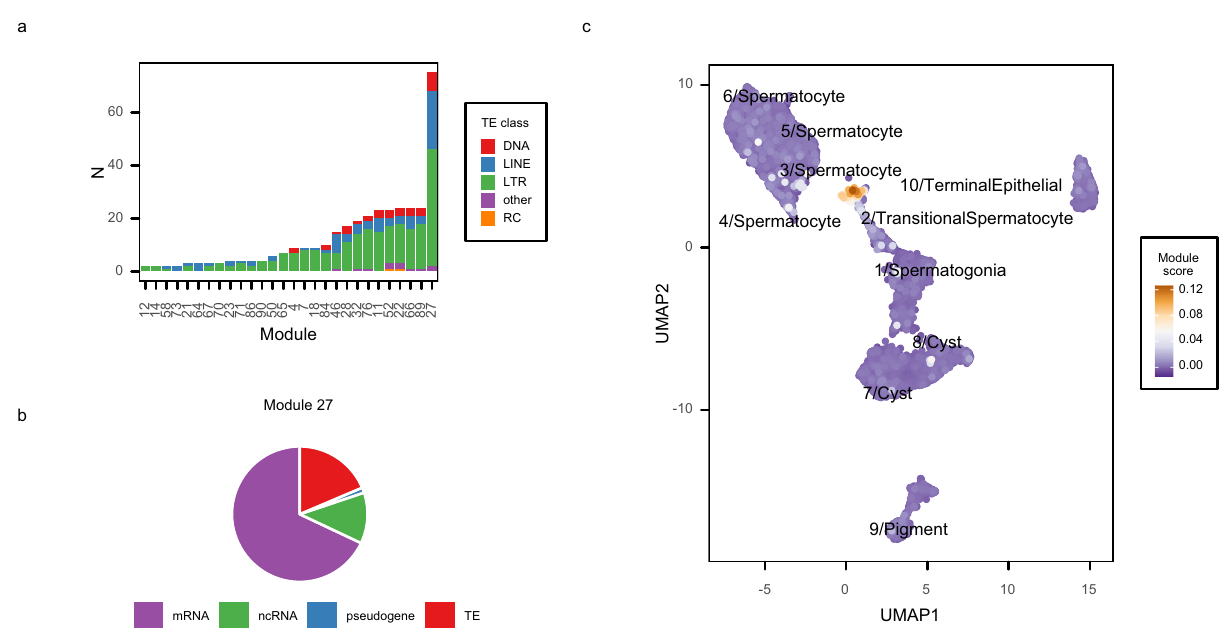
Fig. 3 A TE-enriched expression module is transcribed primarily in cluster 3/Spermatocytes. a Tallies of transposable element (TE) classes found in each module containing at least 1 TE. Module 27 contains almost fourfold more TEs than the next most TE-rich module and is predominantly composed of LTR retrotransposons (59%, 44 out of 75), LINE (29%, 22 out of 75), and DNA (9%, 7 out of 75) elements. b Module 27 contains over 300 features including protein-coding genes (68%), TEs (18.6%), or non-coding RNAs (12%). c UMAP embedding colored by module 27 expression score. Expression score is derived from the consensus Independent Component Analysis source matrix (see Methods). Source data are provided as a Source Data